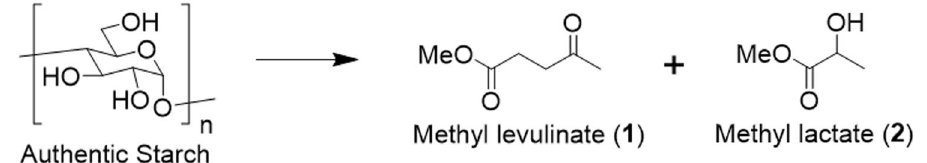
Figure 1. Conversion of an authentic starch sample into methyl levulinate ( 1 ) and methyl lactate ( 2 ).